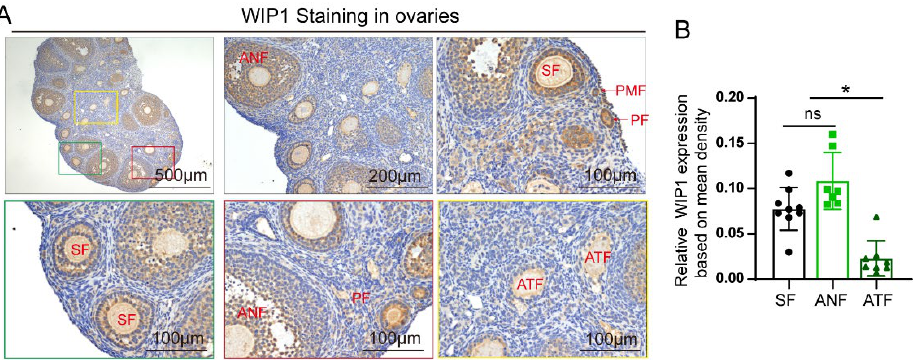
Figure 1. The expression of WIP1 in mouse ovaries. ( A ) Representative images of WIP1 expression in different stages of follicles in the mouse ovaries by IHC. ( B ) Relative WIP1 expression according to mean density (IOD/area). (* p < 0.05, one-way ANOVA) (PMF: primordial follicles, PF: primary follicles, SF: secondary follicles, ANF: antral follicles, THF: total healthy follicles, ATF: atretic folli- cles, CL: corpus luteum) Data are presented as the mean ± SD. * compared with the SF group. * p <